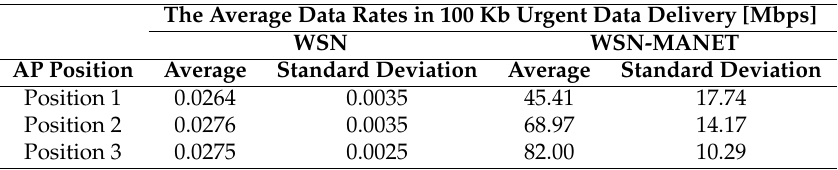
Table 4. The average data rates in 100 Kb urgent data delivery from source WSN sensor to AP. The Average Data Rates in 100 Kb Urgent Data Delivery